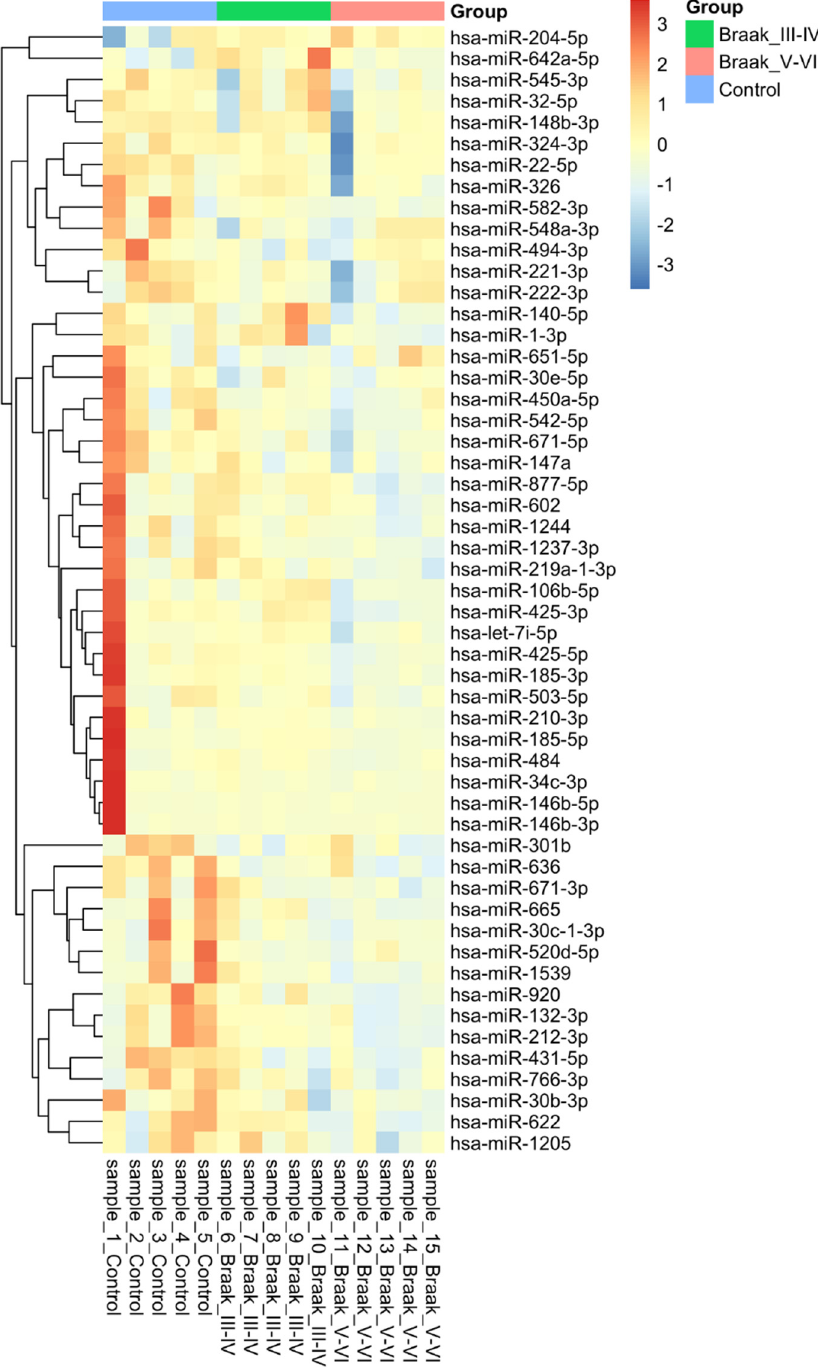
Figure 1. Heatmap showing the expression of 54 differentially regulated microRNAs in Alzheimer’s disease. Fifty-four microRNAs were found using Mann–Whitney statistical analysis across the 2 different comparisons, Control vs. Braak stage III-IV and Control vs. Braak stage V-VI. A p -value of less than 0.05 was considered significant. Hierarchal clustering is present on the left with colours relevant to their group. This was made using heatmap.2 in the R programming language with complete linkage, and Euclidean distance used to compute.